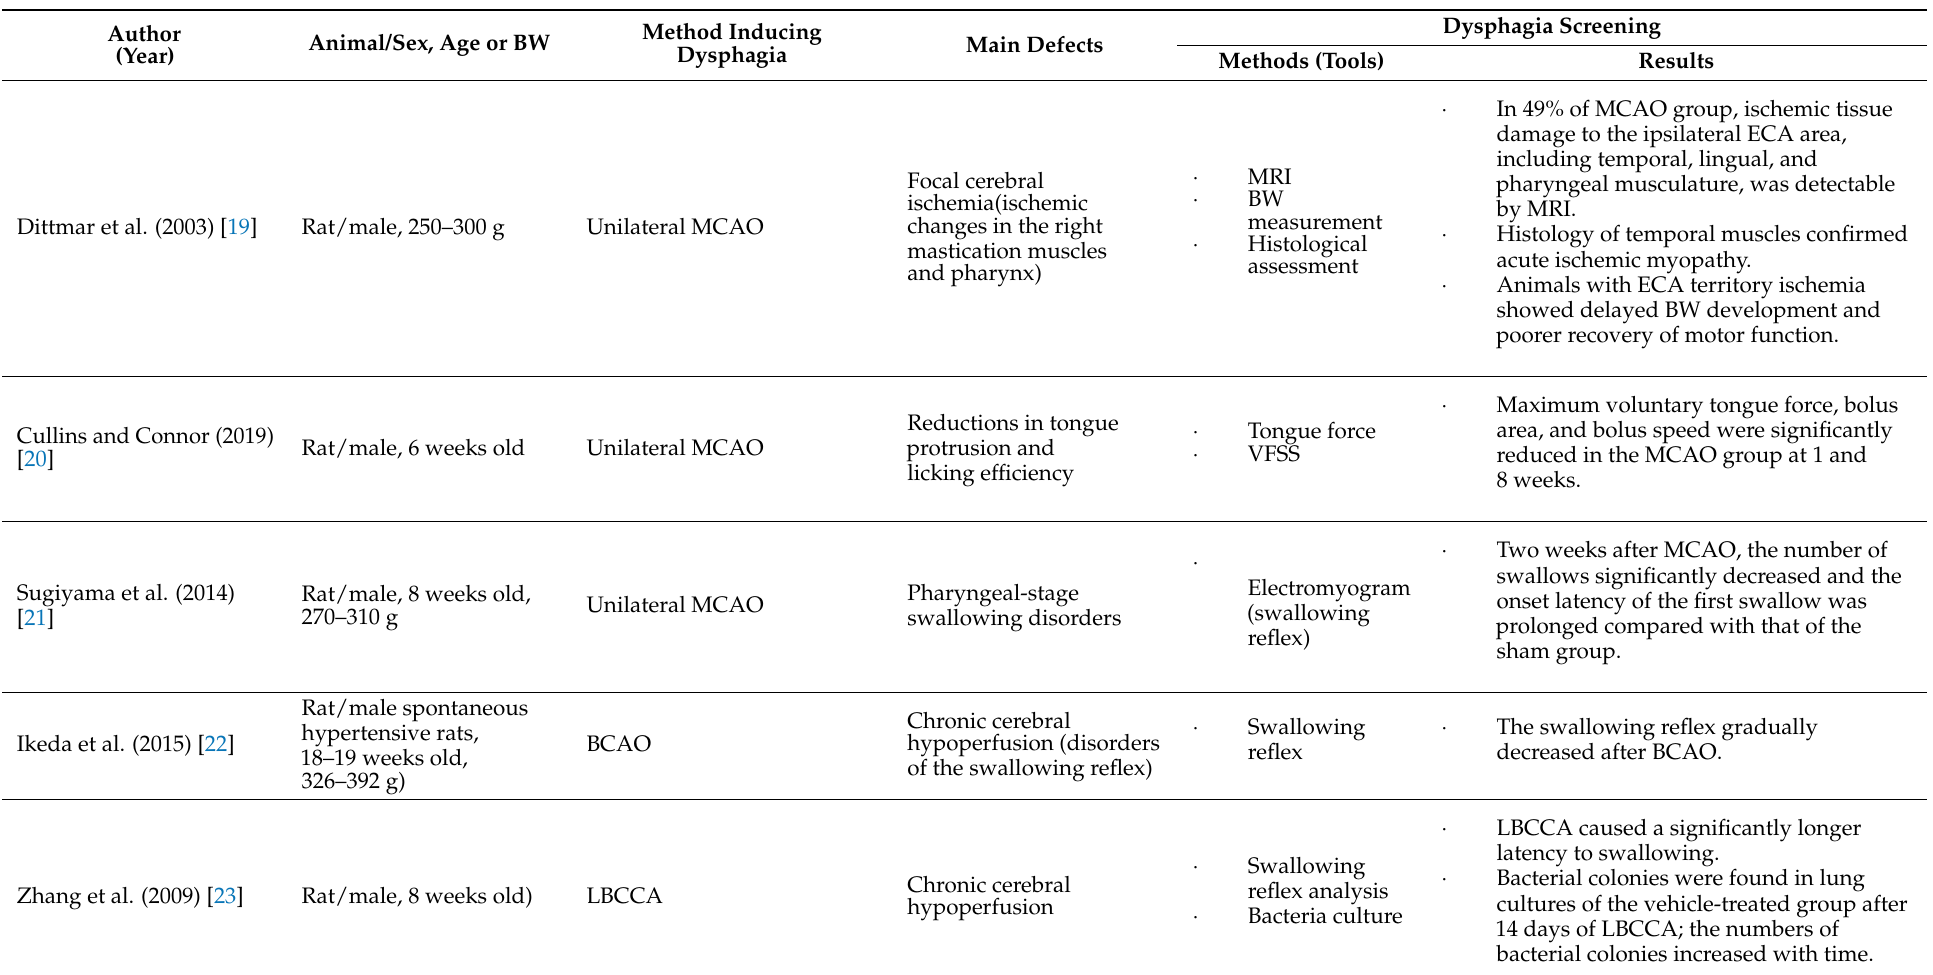
Table 2. Characterization of oropharyngeal dysphagia in rodent models of